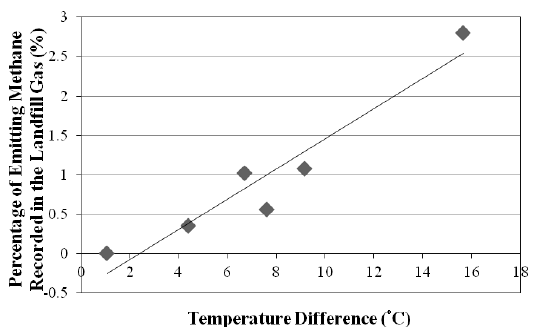
Figure 9. Relationship between the Percentage of Emitting Methane Recorded in GM-17 and the Temperature for 2008 (R 2 = 0.914)